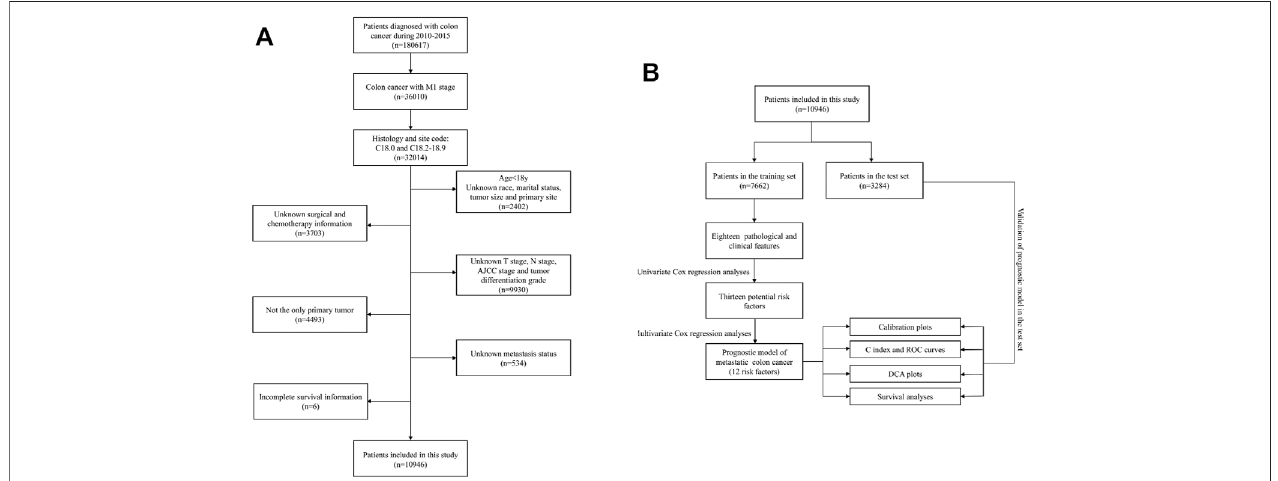
FIGURE 1 | (A) Flowchart of the patient screening process. (B) Flowchart of the research process of this article.